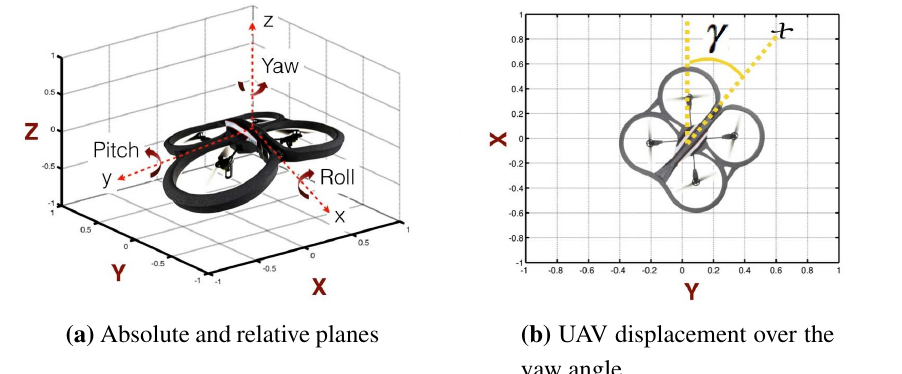
Figure 7. UAV axes: ( a ) difference between absolute axes ( X, Y, Z ) and relative axes ( x, y, z ); ( b ) UAV displacement on the ( x, y ) plane with respect to the absolute